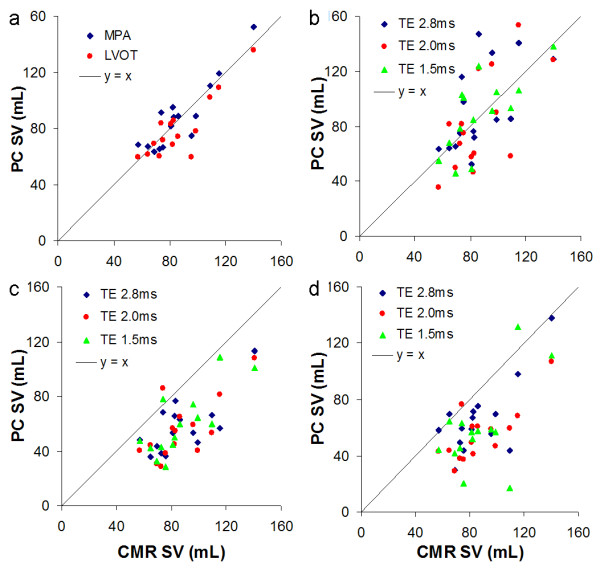
PC SV at serial cardiac locations - MPA/LVOT (a), AoV0 (b), AoV1 (c) and AoV2.5 (d) versus CMR SV. For the AoV0 to AoV2.5 levels the flow obtained using TEs of 1.5 ms, 2.0 ms and 2.8 ms are shown.